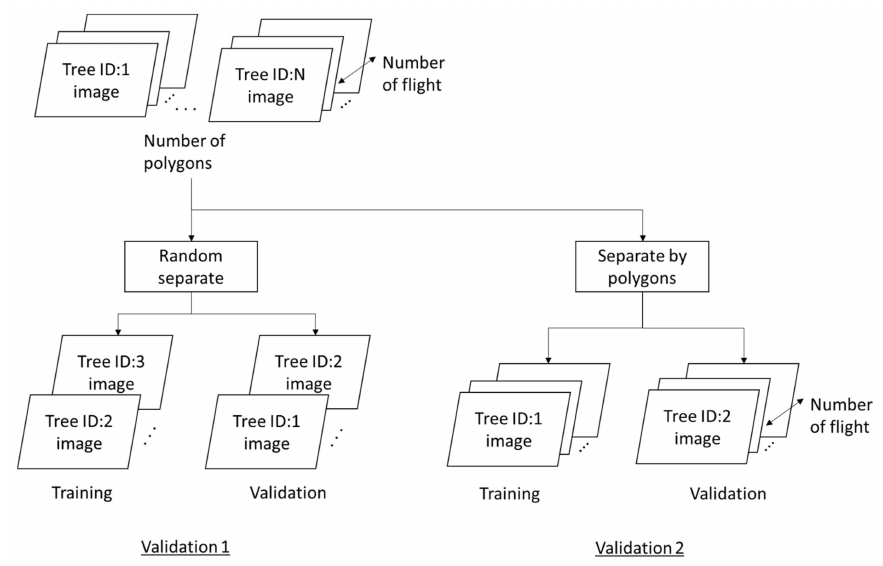
Figure 5. Method for validation dataset separation. The images were extracted from a previous process shown in upper process diagram in Figure 2. In validation 1, training and validation datasets were divided randomly. Thus, this dataset contains the images which were taken at same acquisition date but of different individual trees and images of same individual tree but taken at different acquisition times. In validation 2, the training and validation datasets were divided by polygons. Thus, this dataset contains same acquisition date but with different individual tree